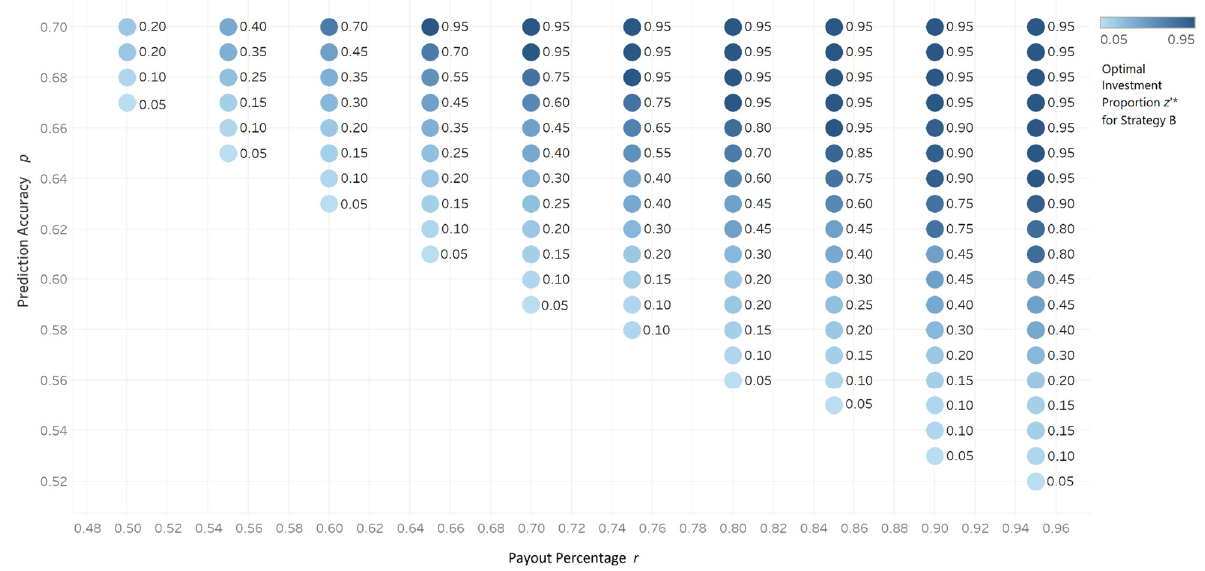
Figure 10. Relation between binary options parameters ( p , r ) and near-optimal investment proportion 𝑧′ ∗ values of strategy B.